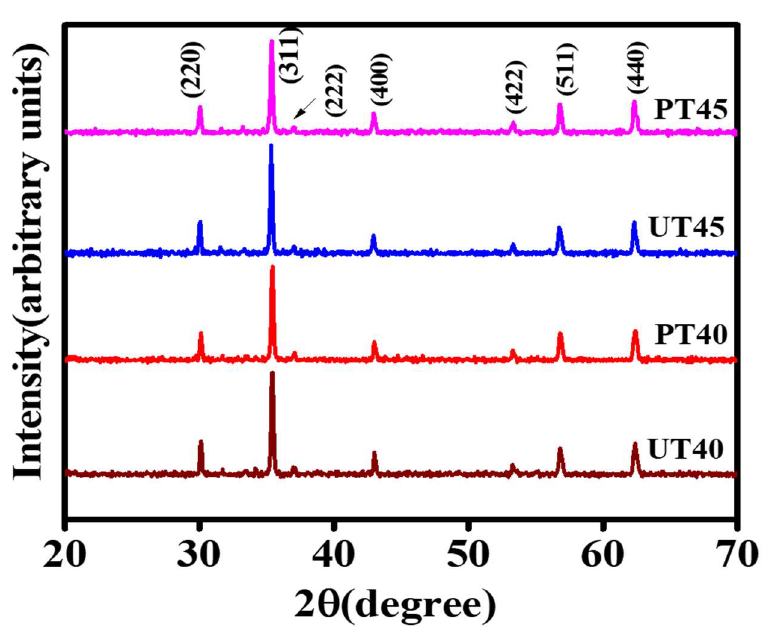
Figure 3. Indexed XRD spectra of pristine and plasma-processed NiCuZn ferrite.